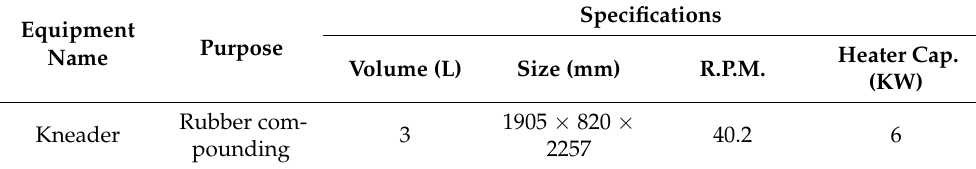
Figure 2. Research flow. Figure 2.